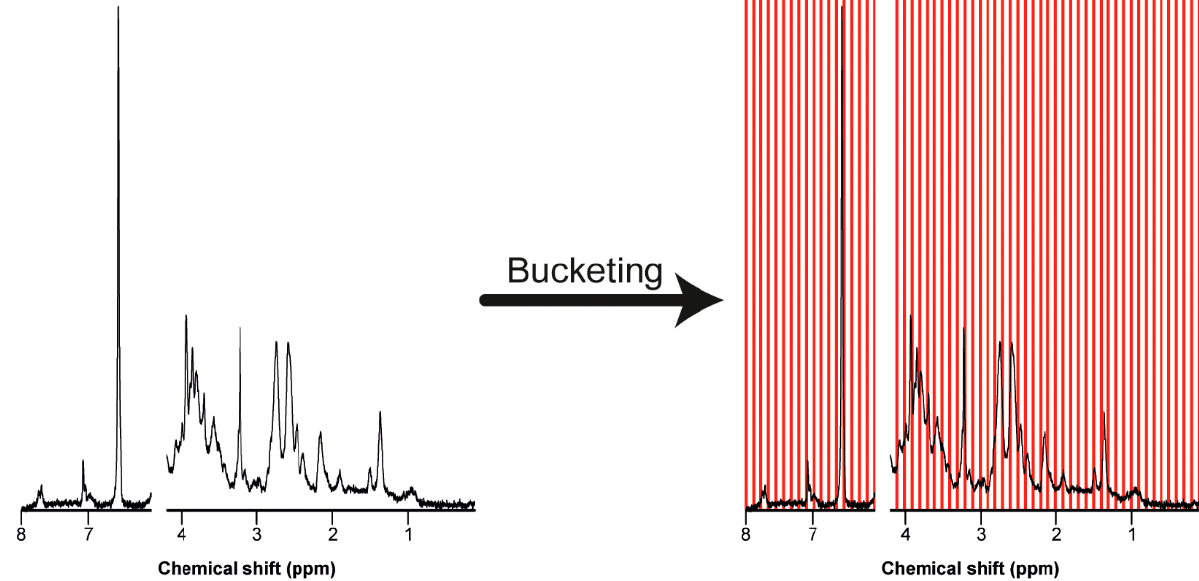
Figure 4. Truncated NMR spectrum before and after bucketing into equally spaced buckets of 0.04 ppm width. Bucketing allows for moderate shift averaging at the expense of resolution and provides a matrix for further processing.